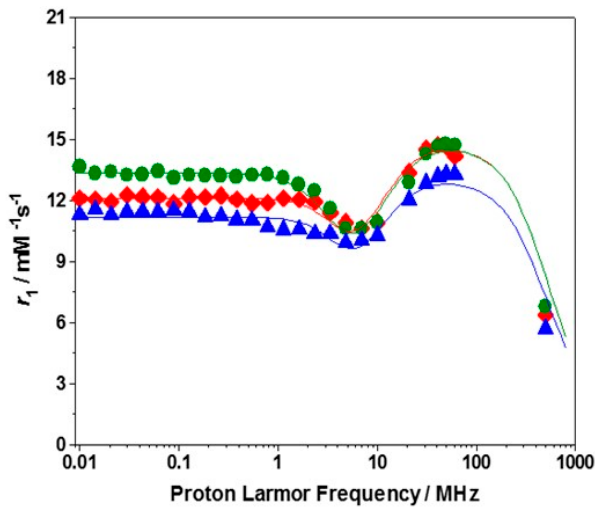
Figure 4. 1/T 1 Nuclear Magnetic Resonance Dispersion (NMRD) profiles for Gd 2 O 3 (red), Gd 2 O 3 :Yb (LL) (green), and Gd 2 O 3 :Yb (HL) (blue) at 310 K. The best-fit curves (solid lines) are calculated using the parameters of Table 2.